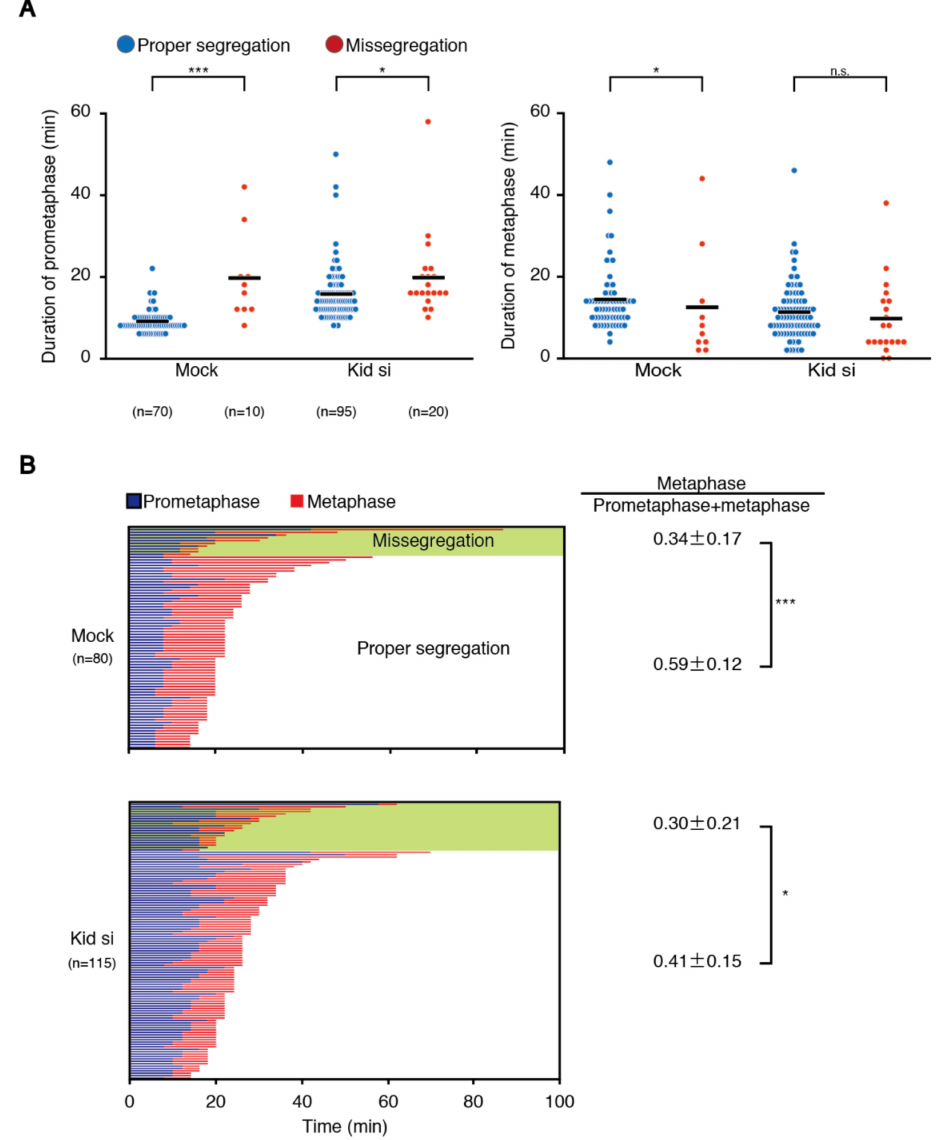
Figure 4. Cells that underwent chromosome missegregation exhibit an elongated prometaphase and a shortened metaphase. ( A ) Duration of prometaphase and metaphase depending on the occurrence of chromosome missegregation. HCT116 cells expressing H2B-mCherry were transfected with or without the siRNA for Kid (#1) and subjected to live cell imaging. Time from nuclear envelope breakdown to anaphase onset was measured in at least 80 mitotic cells for each condition, and categorized by the occurrence of chromosome missegregation. Number of cells observed is shown. The average is indicated with a bar. n.s., not statistically significant, * p < 0.05, *** p < 0.0005 (Mann-Whitney U test); ( B ) duration of prometaphase and metaphase in each cell in ( A ) is indicated with a bar, categorized by the occurrence of chromosome missegregation. Number of cells observed is shown. Ratio of metaphase time to the sum of prometaphase and metaphase time for each category is shown (mean ± SD). * p < 0.05, *** p < 0.0005 (Student’s t -test and Welch’s t